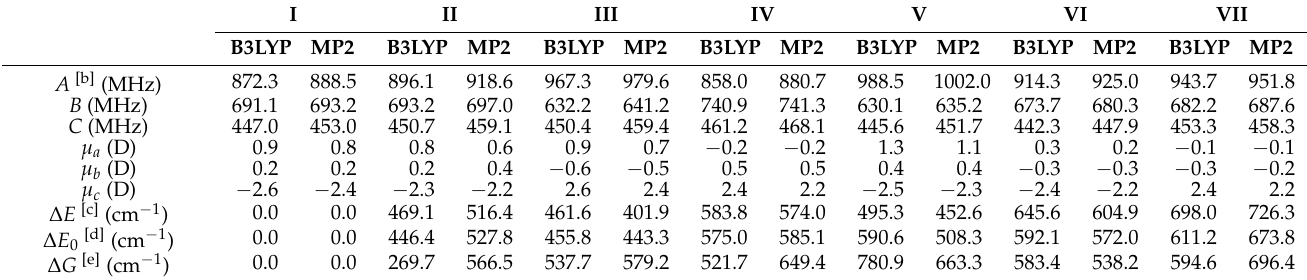
Table 1. Ab initio [a] spectroscopic parameters for the conformers cyclododecanone within 700 cm − 1 .